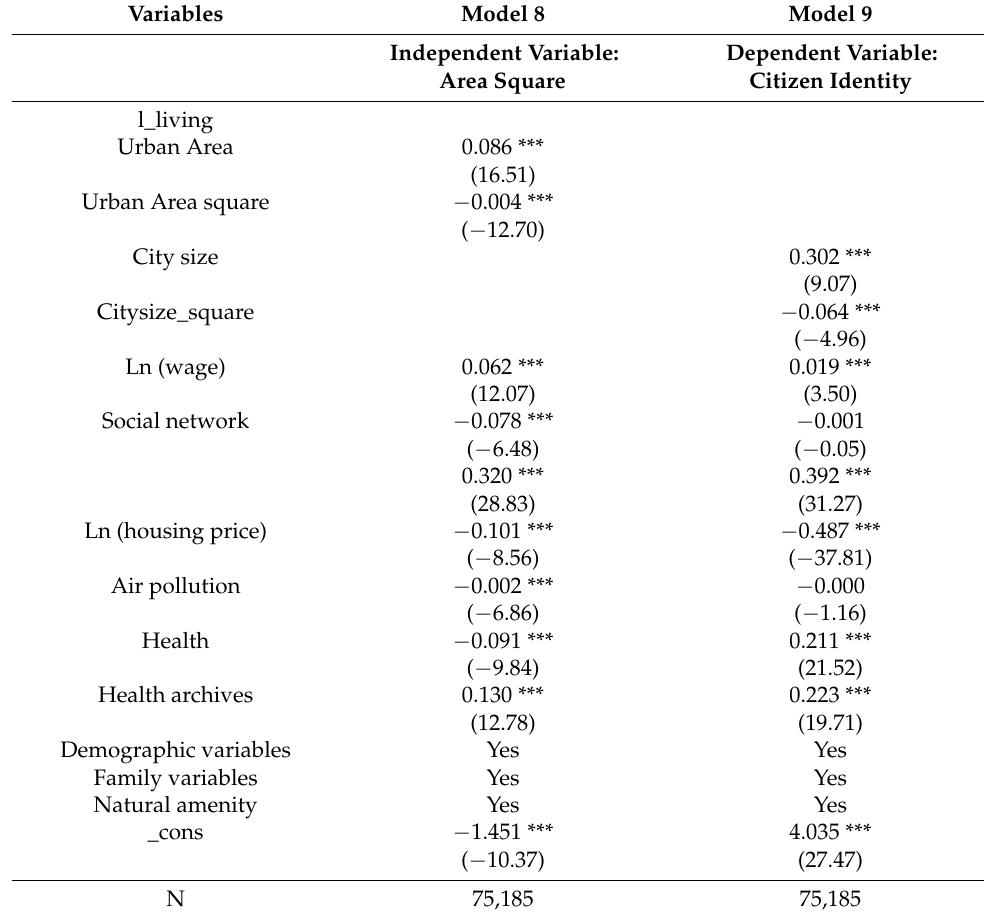
Table 5. The robustness checks of the urban area and citizen